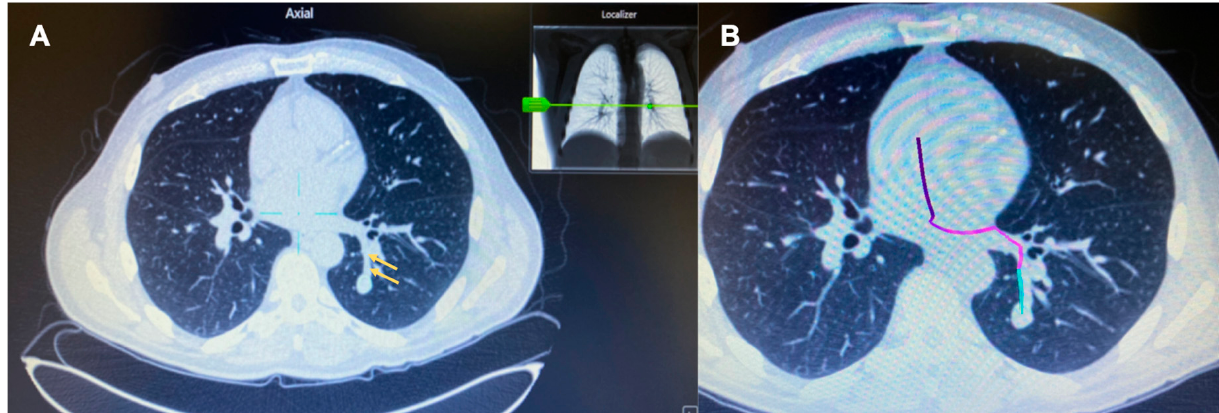
Figure 2. CT image in the axial plane showing the absence of an airway, but presence of a vessel (yellow arrows) leading to the target lesion in the left lower lobe ( A ). Successful mapping of a pathway to the target lesion using the “artery sign” on the on the Medtronic superDimension™ electromagnetic navigation bronchoscopy platform during pre-procedural planning ( B ).